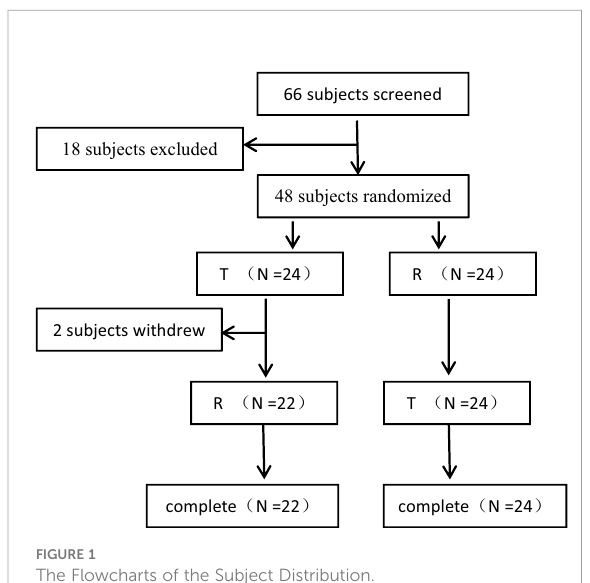
FIGURE 1 The Flowcharts of the Subject